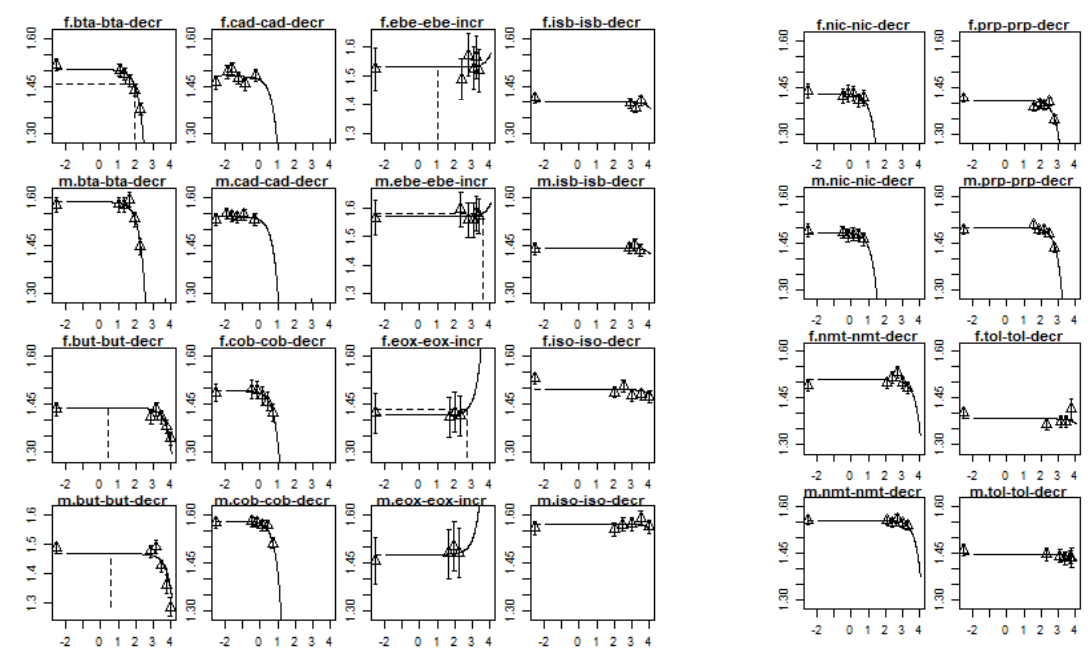
Figure A1. Dose – response curves for the changes in relative liver weight per compound and sex. The x-axis represents the dose in mg/kg bw/day and the y-axis represents the relative liver weight increase in mg organ weight/g body weight, both on a log10-scale. In the header of each plot, m stands for males and f stands for females. The full chemical names are provided in Table A2. Table A2. Relative potency factors based on increased relative liver weight.